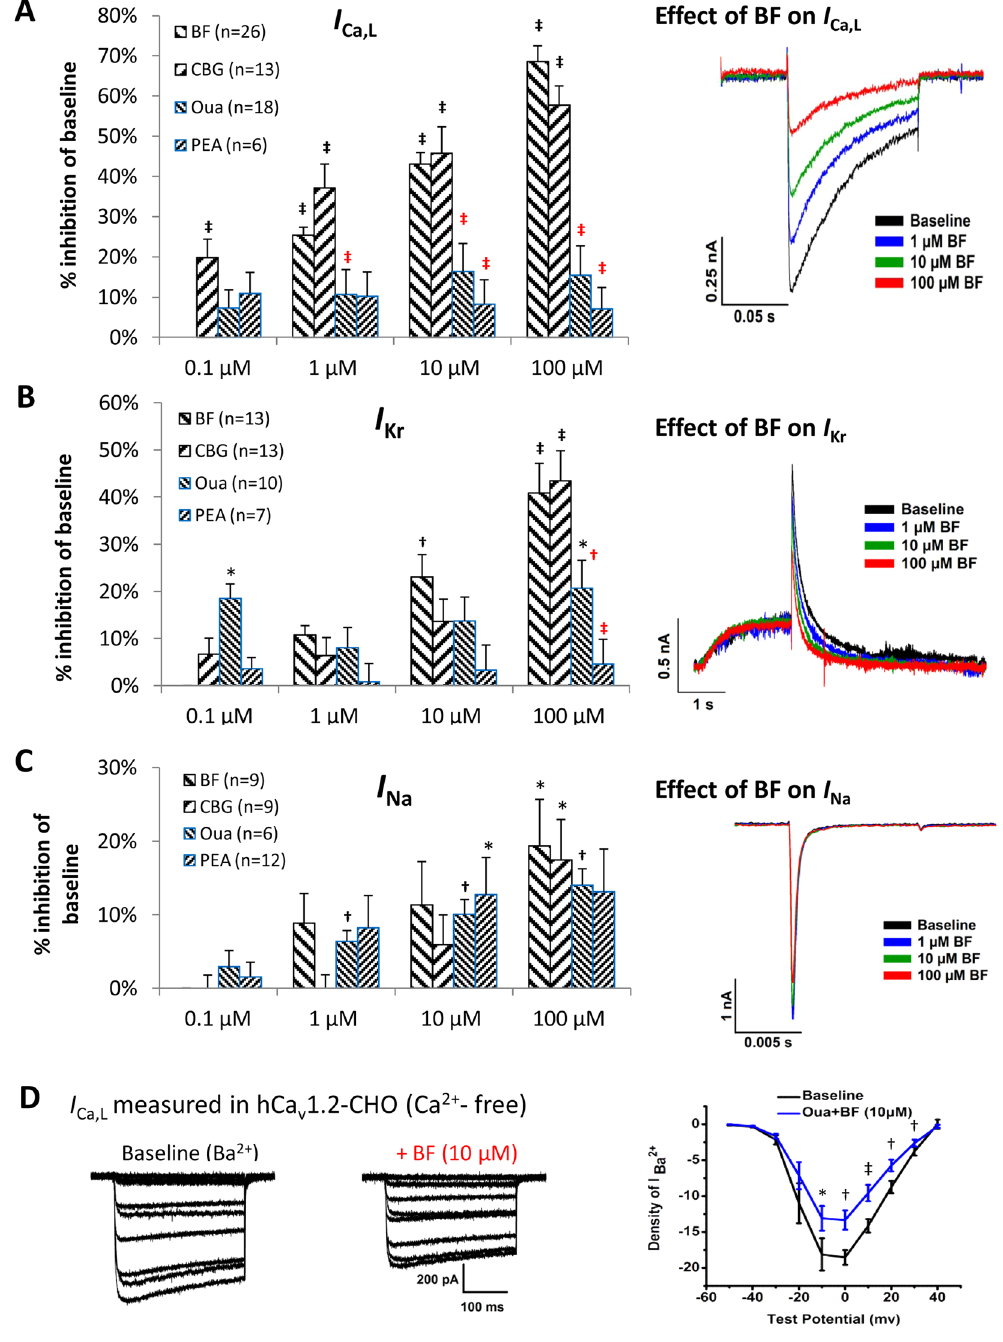
Figure 2. Effects of CGs on I Ca,L , I Na and I Kr in heterologous expression cell lines. ( A ) Effects of BF, CBG, Oua and PEA on I Ca,L recorded from Cav1.2-CHO cells. ( B ) Effects of BF, CBG, Oua and PEA on I Kr (peak tail current) recorded from hERG-HEK293 cells. ( C ) Effects of BF, CBG, Oua and PEA on I Na recorded from Nav1.5-HEK293 cells. Shown on the left are the % inhibitions plotted in bar-graphs. Shown on the right are representative traces showing the effects of BF on I Ca,L , I Na and I Kr recorded by Patchliner ® , the automated patch- clamping system. * p < 0.05, † p < 0.01, ‡ p < 0.001, vs. baseline of each CG (One-Way ANOVA). †(red) p < 0.01, ‡(red) p < 0.001, vs. BF/CBG at same concentrations (Two-Way repeated measures ANOVA). Data are presented as mean ± SEM. ( D ) Effects of BF on I Ca,L recorded in Cav1.2-CHO cells with Ca 2 + depleted in the extracellular solution (recorded by conventional voltage-clamping). (Left) Representative traces of I Ca,L recorded in a Cav1.2-CHO cell at baseline (Ca 2 + -free extracellular conditions achieved by using BaCl 2 to replace CaCl 2 ) and post 10 µ M BF treatments. ( Right) I-V curves showing the voltage-dependent I Ca,L current densities (pA/pF). * p < 0.05, † p < 0.01, ‡ p < 0.001, vs.